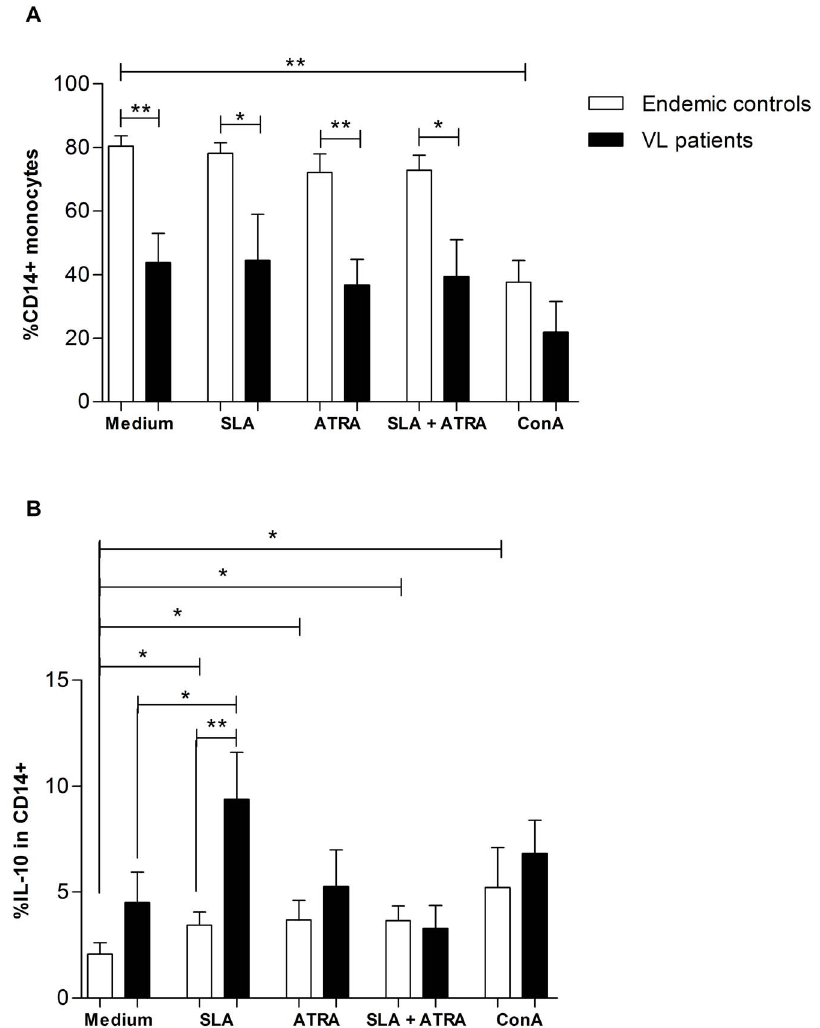
Figure 5. IL-10 expression in CD14 + monocytes after different stimuli. A . Significant reduced frequency of CD14 + monocytes in VL patients. B . IL-10 production in CD14 + monocytes after tested conditions Mann-Whitney test was used to compare endemic controls to VL patients. Wilcoxon matched pairs test was used to compare cultures stimulated and non-stimulated within the studied groups. * p , 0.05; ** p , 0.01. Bars represent median and IQR. ATRA = all-trans retinoic acid. SLA = Soluble Leishmania antigens (SLA). ConA = Concanavalin